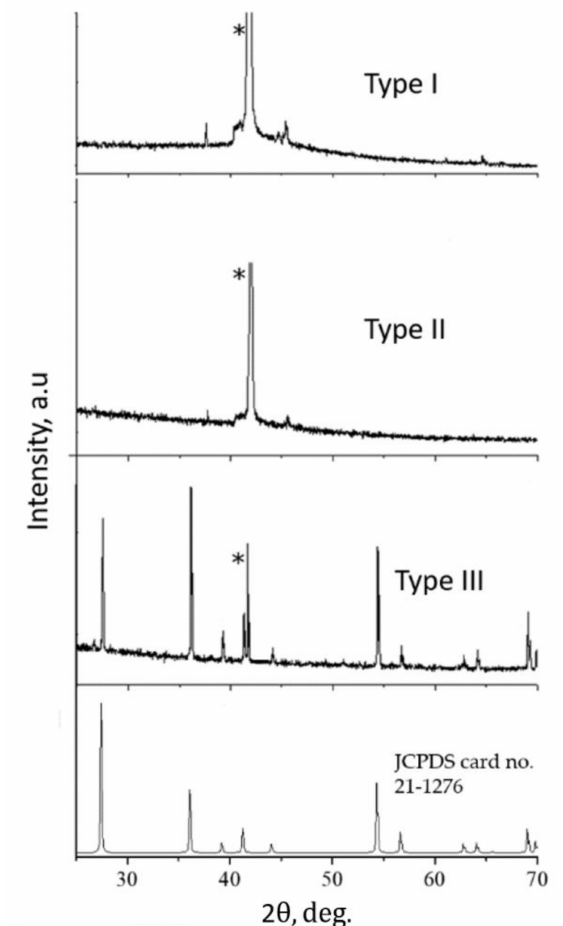
Figure 2. X-ray diffraction pattern of the corresponding samples. * designates reflection of the sapphire